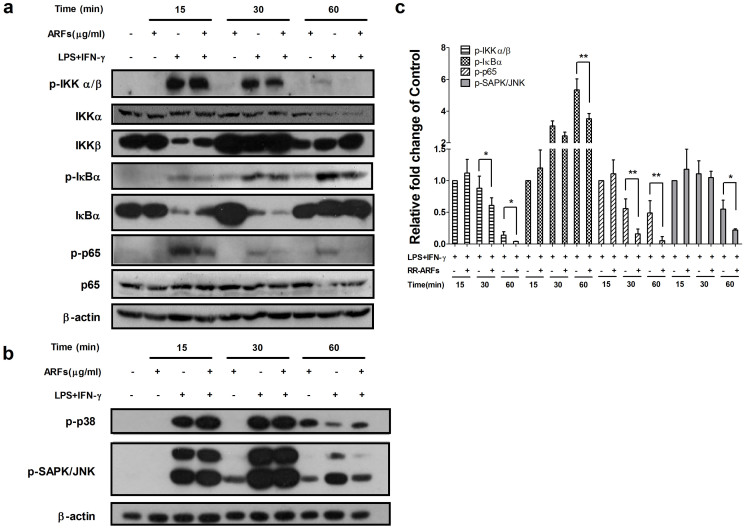
Effects of RR-ARFs on IKK and MAPK signaling in LPS/IFN-γ-stimulated RAW264.7 cells.Cells were stimulated with LPS/IFN-γ in the absence or presence of RR-ARFs (200 μg/ml) for the indicated time. The protein levels of phospho-IKKα/β (85–87 kDa), IKKα (85 kDa), IKKβ (87 kDa), phospho-IκBα (40 kDa), IκBα (39 kDa), phospho-p65 (65 kDa), p65 (65 kDa), phospho-p38 (43 kDa) and phospho-JNK (46 and 54 kDa) were detected by Western blot analyses using their respective antibodies (a and b). β-actin was used as an internal loading control. The full-length blots with those antibodies were presented in supplementary Figure S2. All gels have been run simultaneously under the same experimental conditions. Cell culture experiments were performed at least three times. Western blot data was quantitated to better view the difference between different treatment groups. Data represent means ± SEM; * P < 0.05, ** P < 0.01, *** P < 0.001 (c).